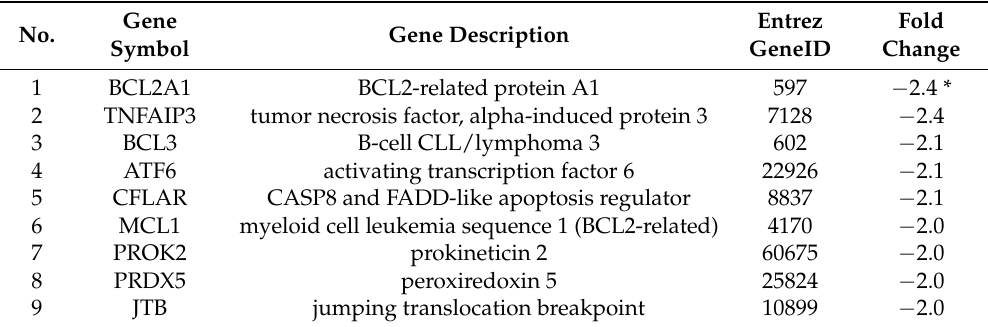
Table 4. The list of anti-apoptotic/pro-survival genes with the largest change of expression (at least 2 folds) in CD34+ cells from GHD patients prior to GH-TS compared to their controls. No.